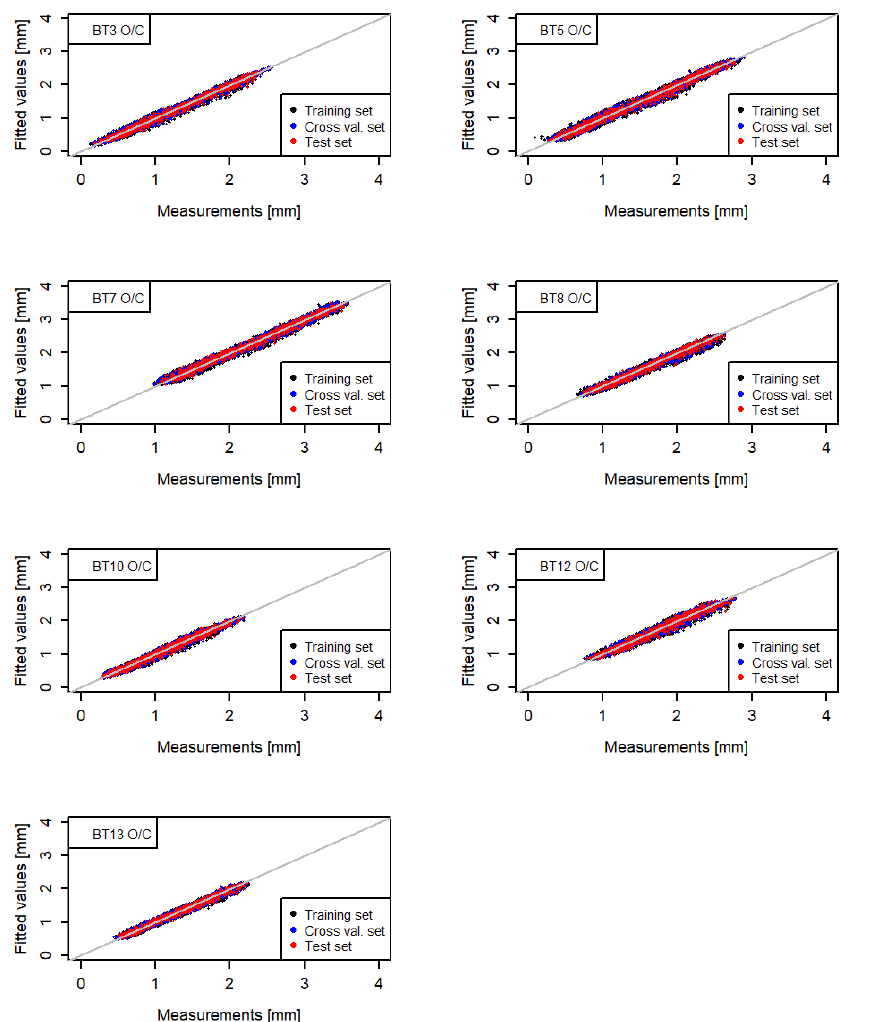
Figure 14. Fitted values vs. recorded values for the movements measured through 3D